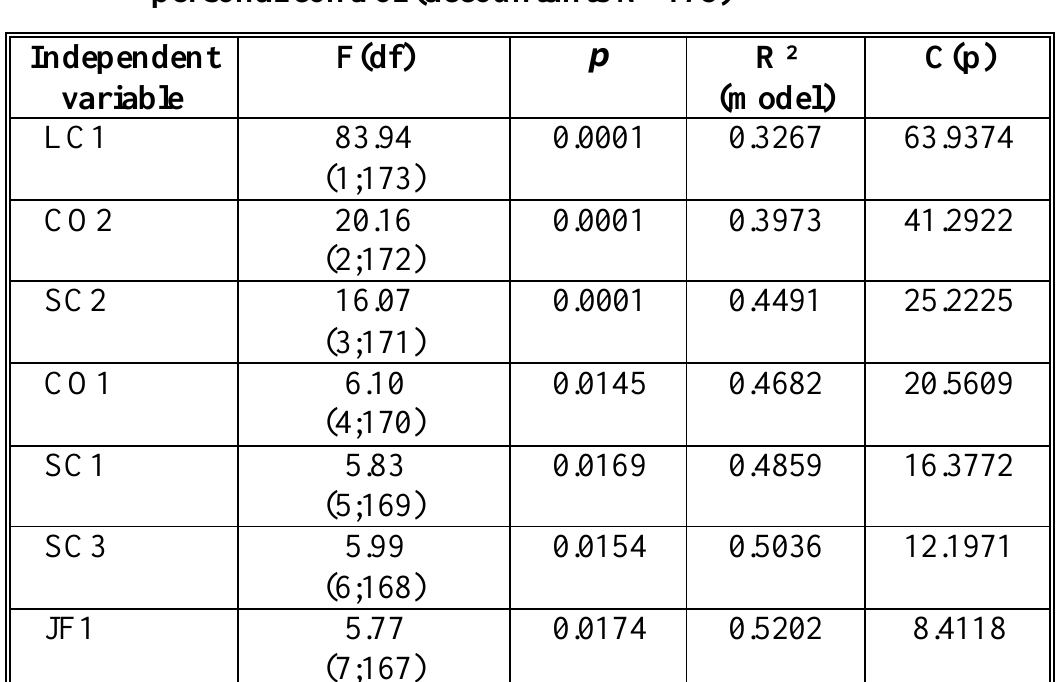
Dependent variable: Entrepreneurial attitude 2: Achievement/ personal control (accountants